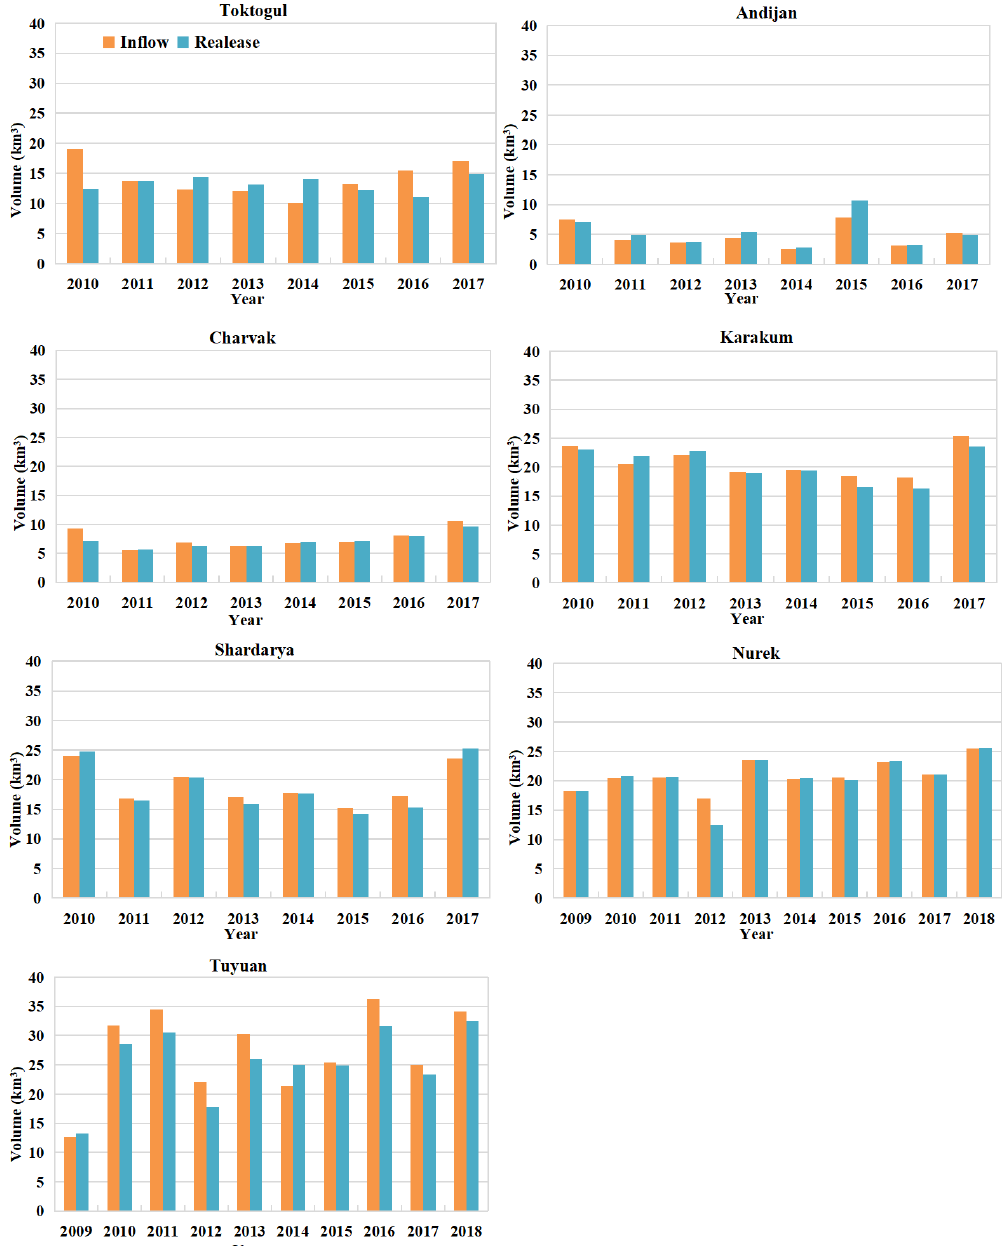
Figure 3. Changing inflow and outflow trends in major reservoirs of Central